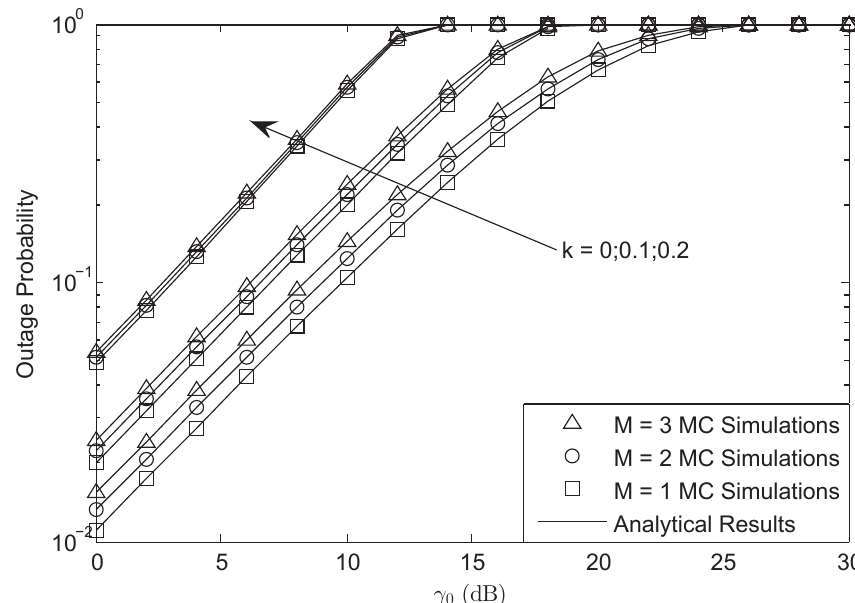
Figure 5. OP of the system versus different γ 0 with σ = 0.8, γ = 30 dB and L = 10: FHS. Figure 6 plots the OP of the system versus different γ with M = 3, σ = 0.8, γ 0 = 3 dB and L =